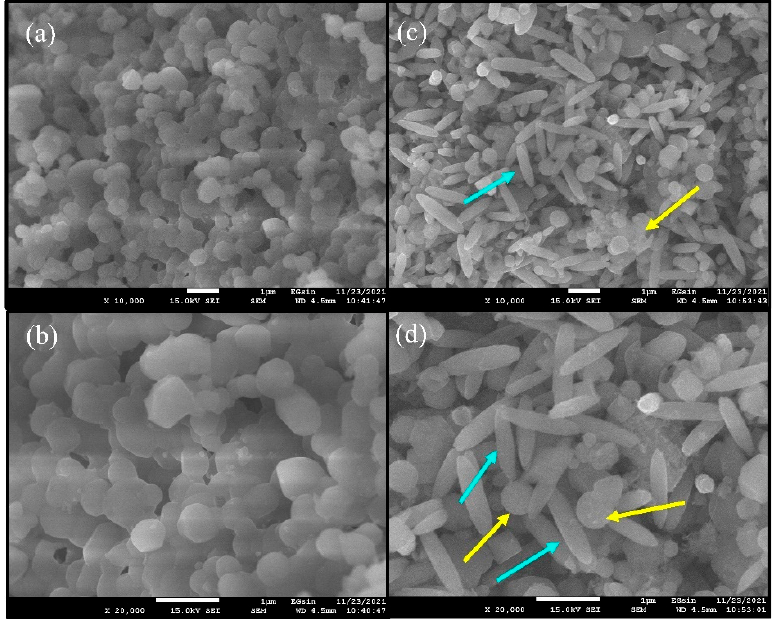
Figure 2. FE-SEM images of ( a , b ) HAP and ( c , d ) HAP-MnFe 2 O 4 at low and high magnifications. The yellow arrows indicate HAP nanoparticles, whereas the cyan arrows MnFe 2 O 4 in the HAP-MnFe 2 O 4 nanocomposite.